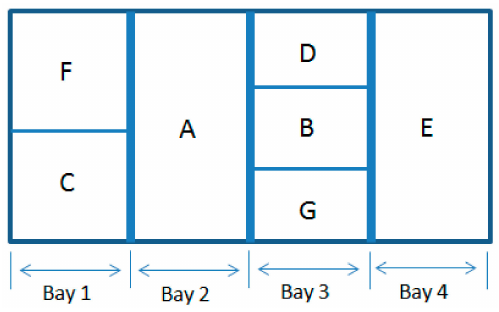
Figure 1. An example of unequal sized facility layout.